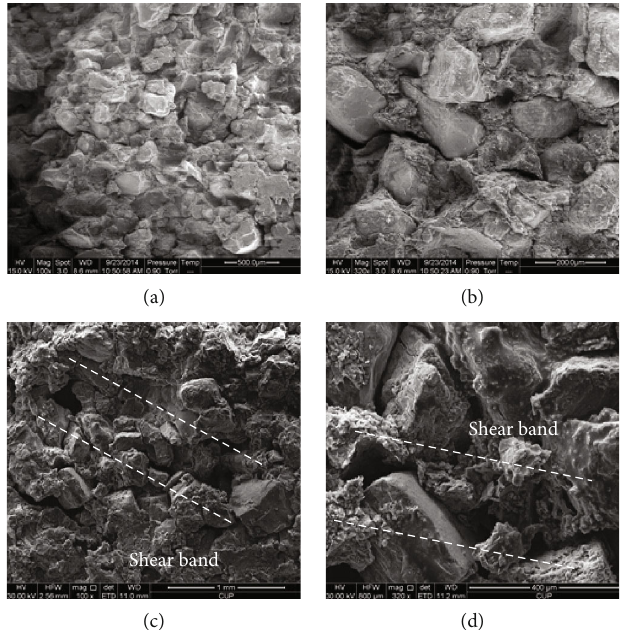
Figure 4: Microstructures of Karamay oil sands before and after shear dilation.